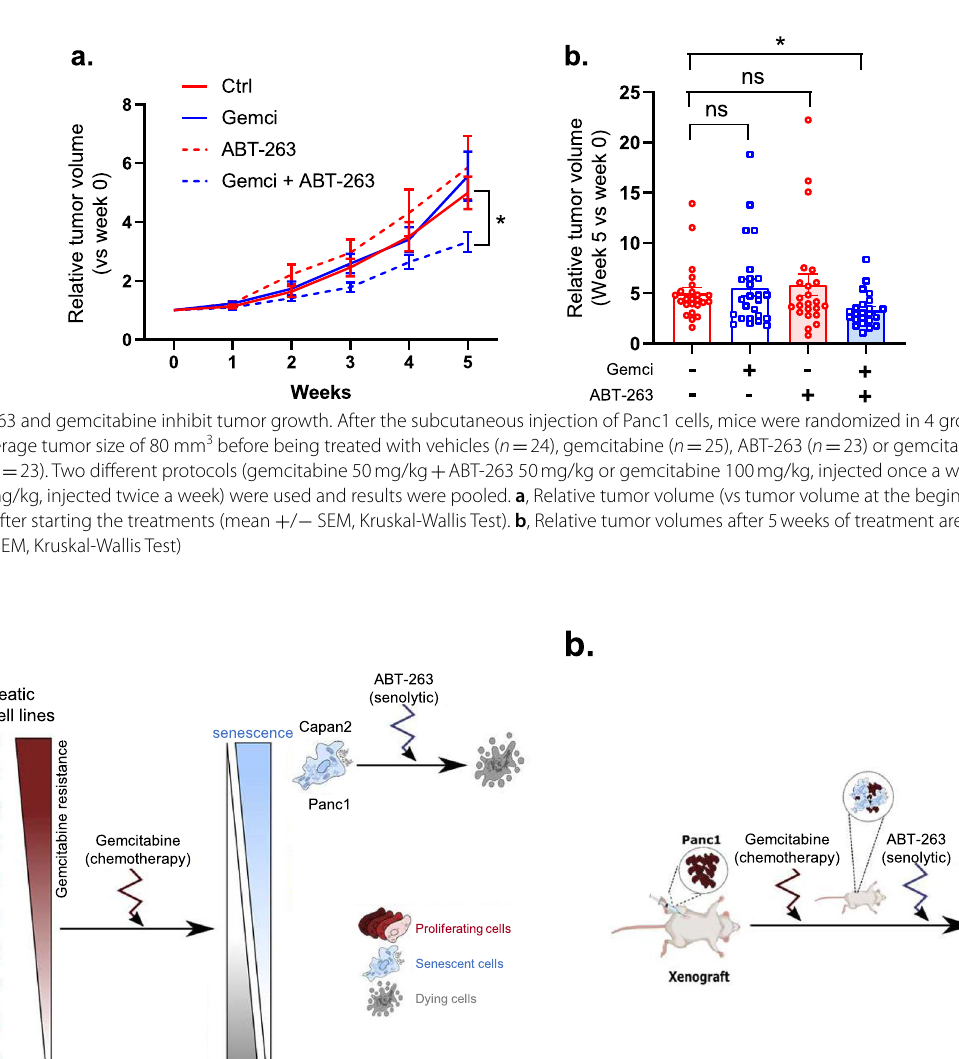
Fig. 7 Schematic summary of the results. a , in vitro results. b , in vivo results. This figure has been generated using Inkscape